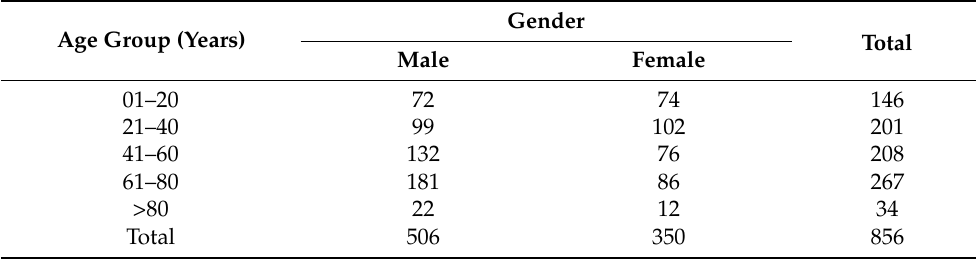
Table 1. Gender-wise and age group-wise distribution of coronavirus disease 2019 (COVID-19) patients in intensive care unit